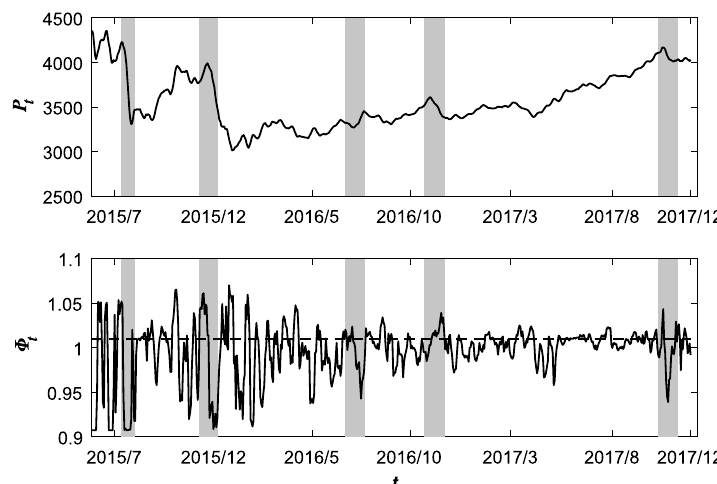
Fig. 4 Realized price (top panel) and the corresponding average market sentiment (bottom panel) for the model specification x s = q ( 0.2 ) , n s , max = 0.3 . The average market sentiment is given